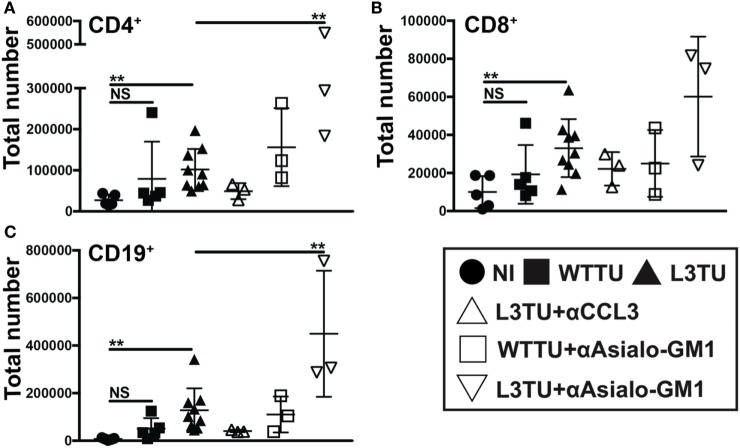
The enhanced accumulation of leukocyte subsets in the L3TU tumor-draining lymph node (TDLN) is negated by blocking CCL3, but enhanced by natural killer (NK) depletion. (A–C) Absolute numbers of immune cell subsets in the TDLN 5 days post-tumor injection of mice with and without the anti-CCL3 blocking Ab or NK cell (anti-Asialo-GM1) depletion Ab. N = 3 mice per cohort. NI (circles), WTTU (squares), and L3TU (triangles) cohorts were conducted concurrently along with the CCL3-blocking and NK depletion cohorts. IgG1a antibody was administered to WTTU, and L3TU cohorts as controls. Not significant (ns), p > 0.05; *p = 0.01–0.05; **p = 0.001–0.01; ***p = 0.0001–0.001; ****p < 0.0001.